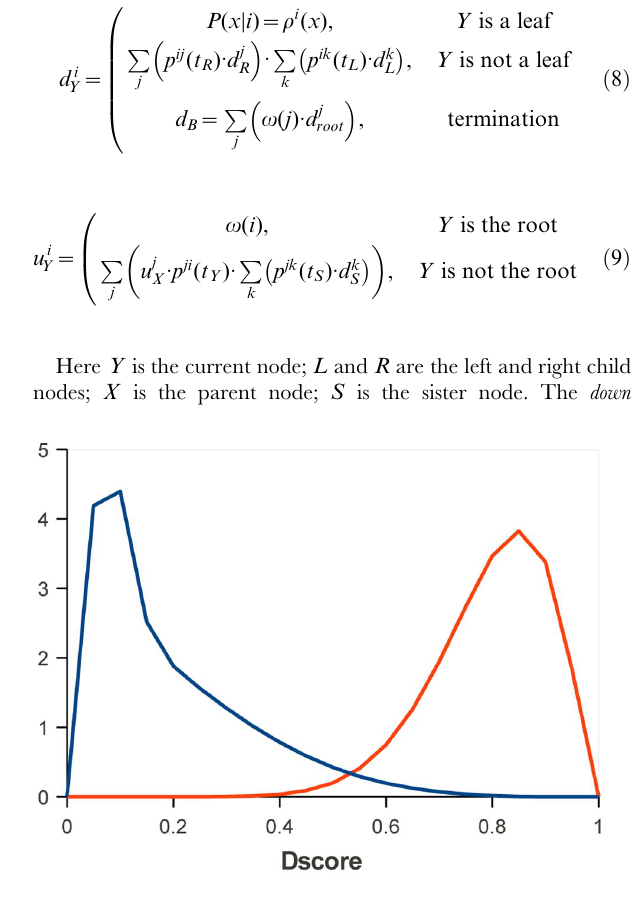
Figure 4. Score distributions for states. The blue line corresponds to the SignalP Dscore distribution of the N state (no signal peptide); the red one, to the distribution of the SP state (signal peptide present). doi:10.1371/journal.pone.0065012.g004 PLOS ONE |